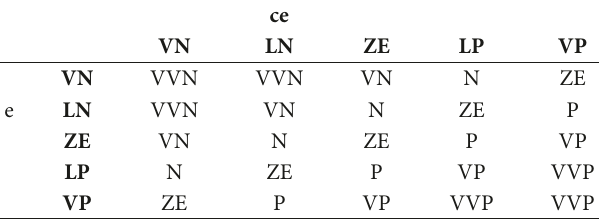
Table 1: Rule base for